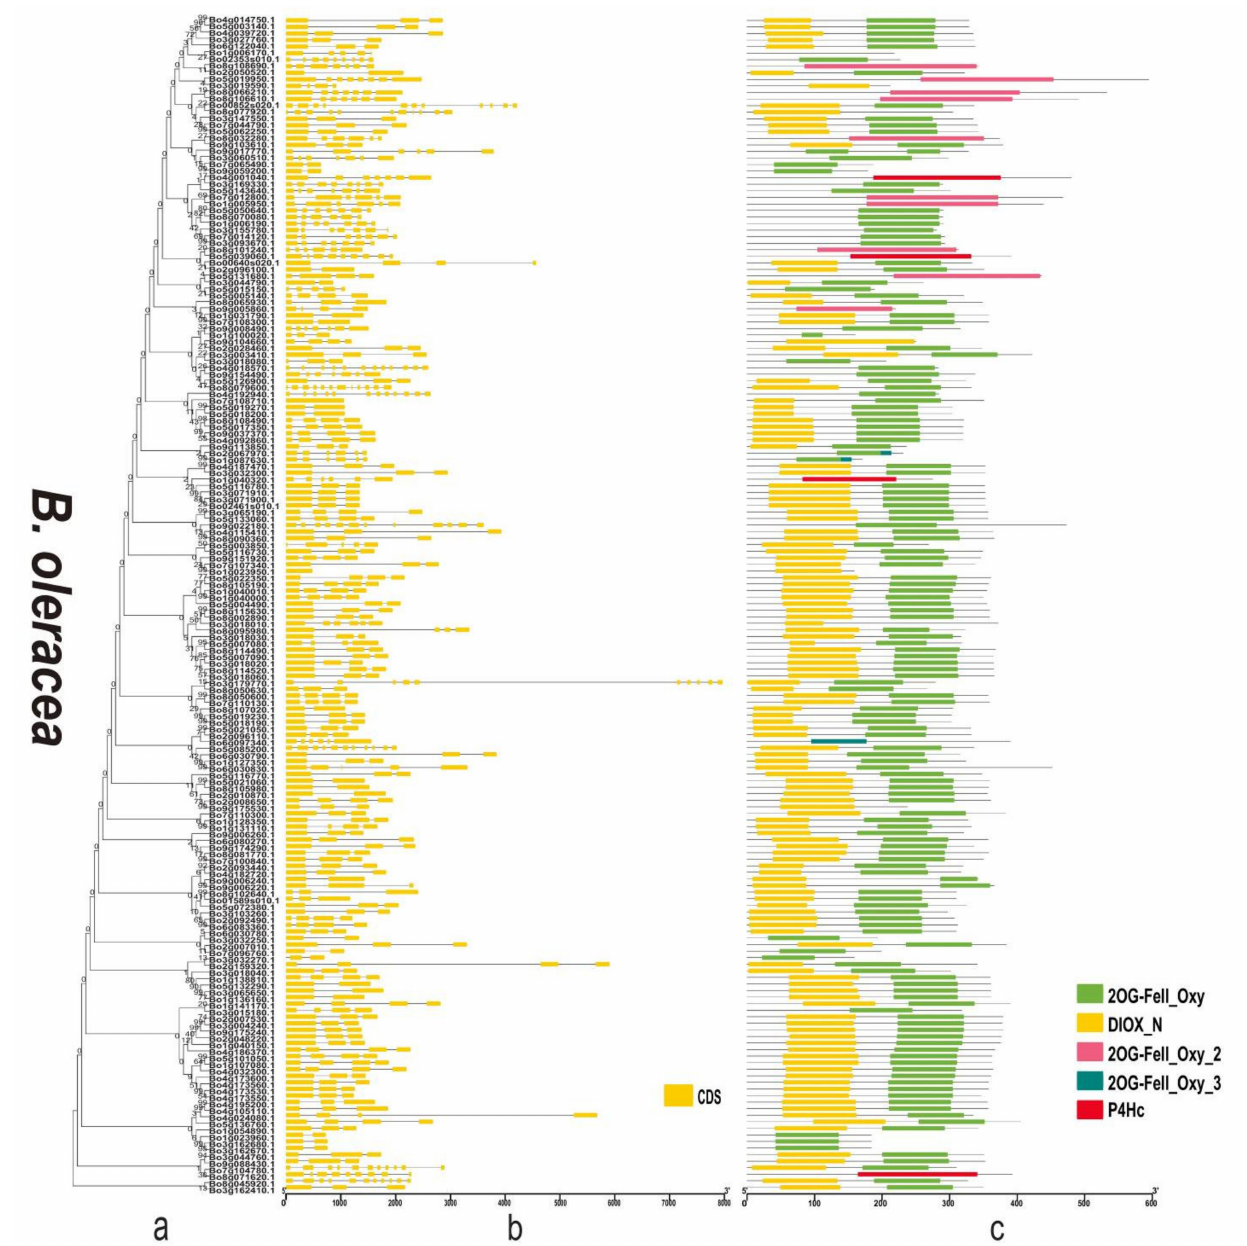
Figure 8. Phylogenetic relationships, gene structure, and domains in the 2OGD genes from B. oleracea . ( a ) The phylogenetic tree was constructed based on the full-length protein sequences of 2OGDs using MEGA-X software. ( b ) Exon-intron structure of the 2OGD genes. Green boxes indicate untranslated 5 (cid:48) - and 3 (cid:48) - regions; yellow boxes indicate exons; and black lines indicate introns. ( c ) The domain composition of the 2OGD proteins. The domains DIOX_N and 2OG-FeII_Oxy. Some genes that only have 2OG-FeII_Oxy_2, 2OG-FeII_Oxy_3, or P4Hc are displayed in different coloured boxes. The length of proteins can be estimated using the scale at the